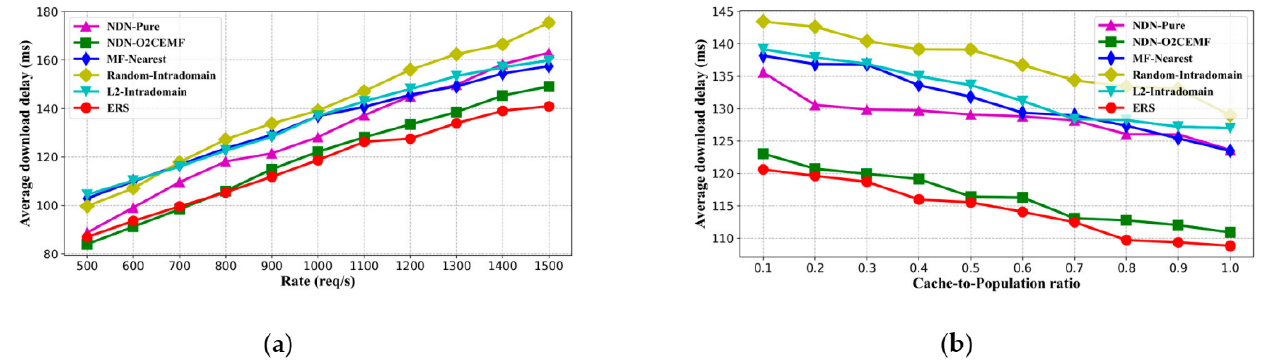
Figure 9. Average content download delay comparison with different impact factors on YouTube video traffic dataset. ( a ) Request rate and ( b ) cache-to-population